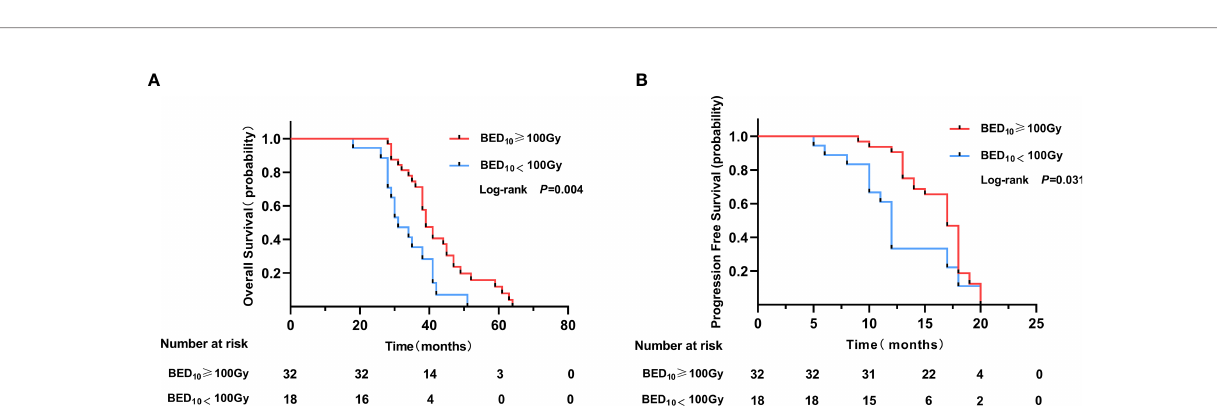
FIGURE 4 | Overall survival and progression free survival of primary tumors treated with BED 10 ≥ 100 Gy (A) or BED 10 <100 Gy (B) in the TKIs + LCRT